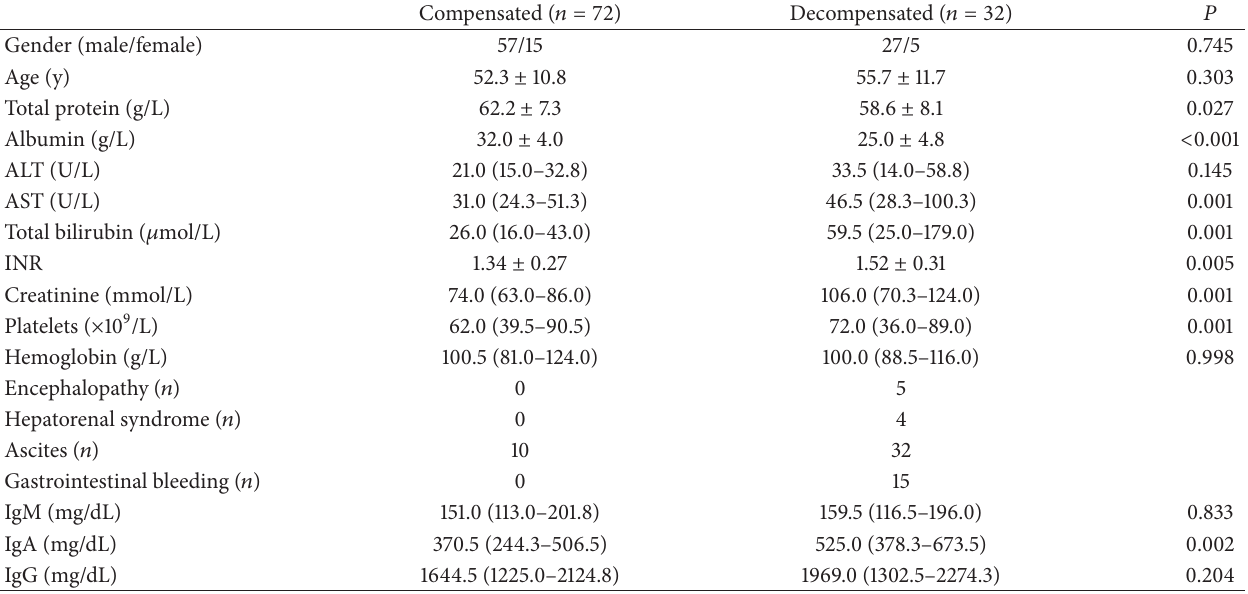
Table 2: Demographic and clinical characteristics of HBV-infected patients with compensated and decompensated cirrhosis at